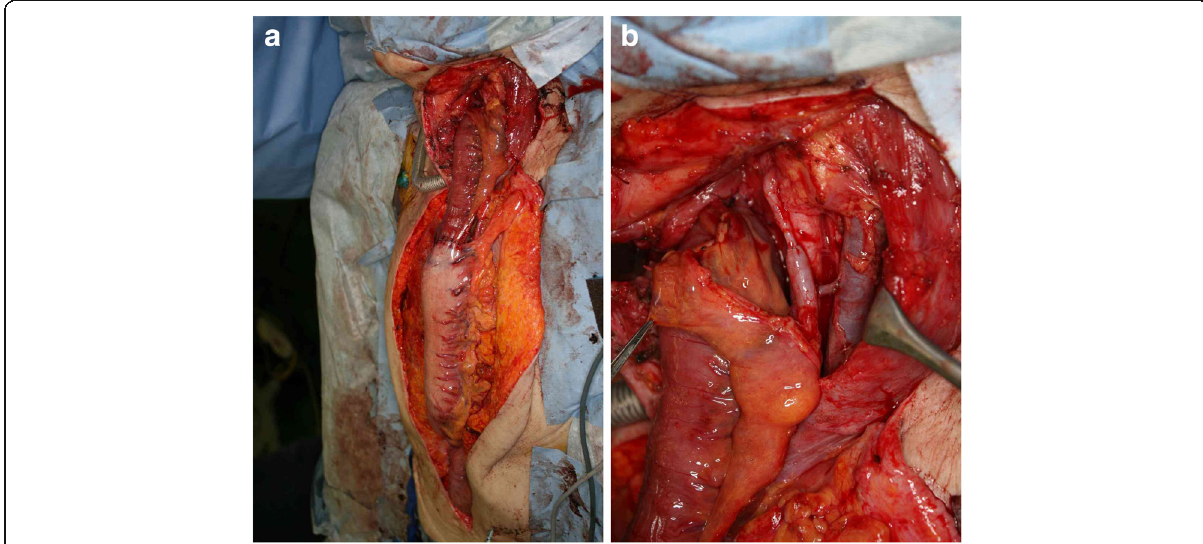
Fig. 6 Findings of the reconstruction operation. a Reconstruction via an anterior thoracic route with free jejunum interposition and gastric tube. b Vascular anastomosis of the feeding artery and drainage vein of free jejunum. End-to-end anastomosis of the jejunal artery and left superior thyroid artery. End-to-side anastomosis of the jejunal vein and left internal jugular